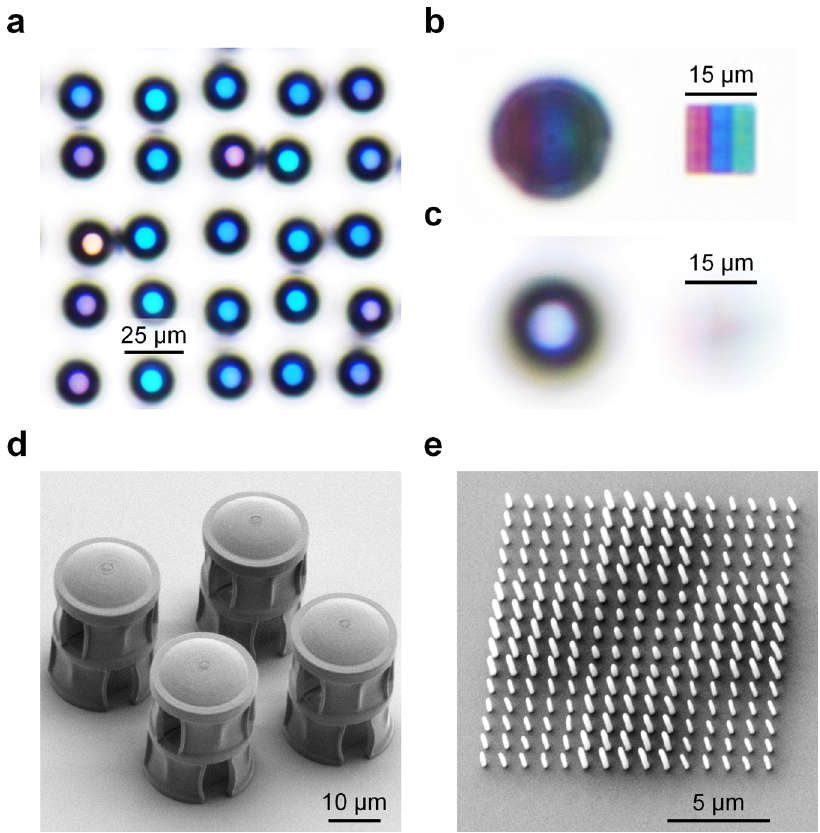
Fig. 3 Optical and electron micrographs of the light fi eld print. a Bright fi eld transmission optical microscope image (plan-view) of the display units in a pseudorandom arrangement. b , c Bright fi eld transmission optical microscope images of a display unit (left) and a block of structural colour pixels designed with red, blue, and green stripes (right). The same pixels were patterned beneath the microlens of the display unit. b The optical microscope image was focused on the pixels. c The optical microscope image was focused on the front focal plane of the display unit. d Scanning electron microscope (SEM) image (45° tilt angle) of 2 × 2 display units. e SEM image (30° tilt angle) of 3 × 3 pixels, in which each pixel is recognizable by 5 × 5 nanopillars with the same height and